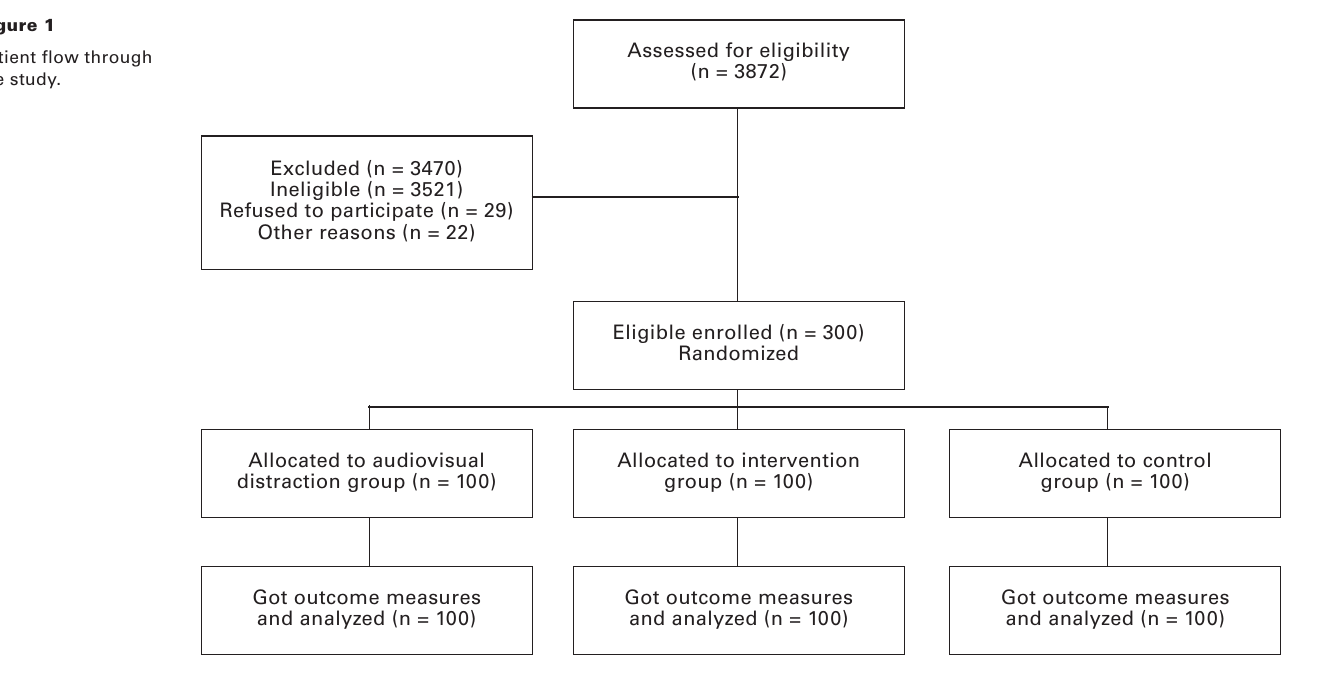
son, times of venepuncture showed no significant difference between the audiovisual distraction the control group (VAS score: 5.22 ± 2.53) com- vention groups (VAS score: 4.55 8 2.26 and 4.38 Table 3 Baseline characteris- tics of patients.